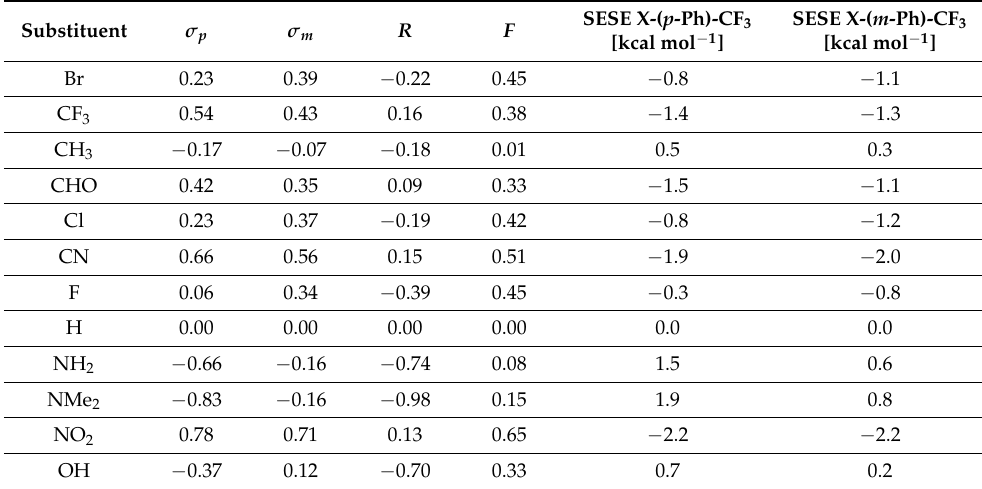
Table 1. Examined substituents and values of their substituent constants and SESE descriptors in p - or m -substituted benzene derivatives [2,24].